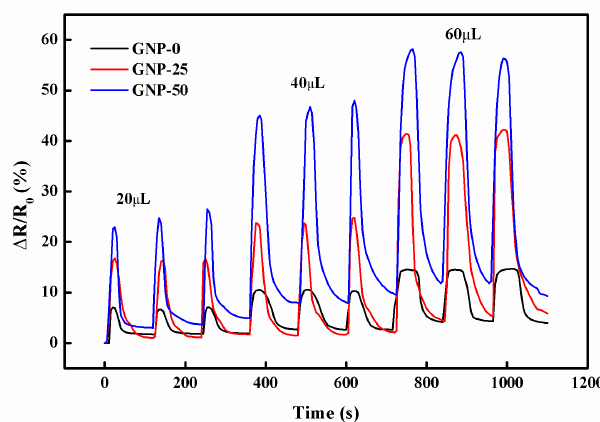
Figure 17. Resistance changes of the hybrid films in consecutive cycles of infiltration and evaporation of acetone drops.